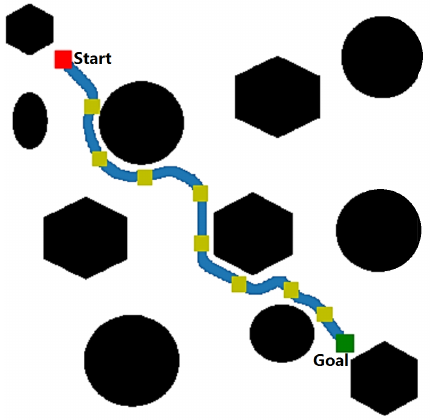
Figure 19. Full path planed in unknown